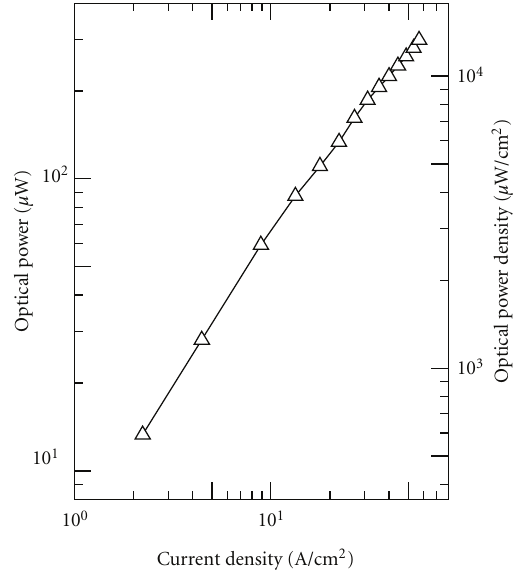
Figure 3: Emission power and power density dependence of the injection current density of a p-Si/SiO 2 /n-Si diode.